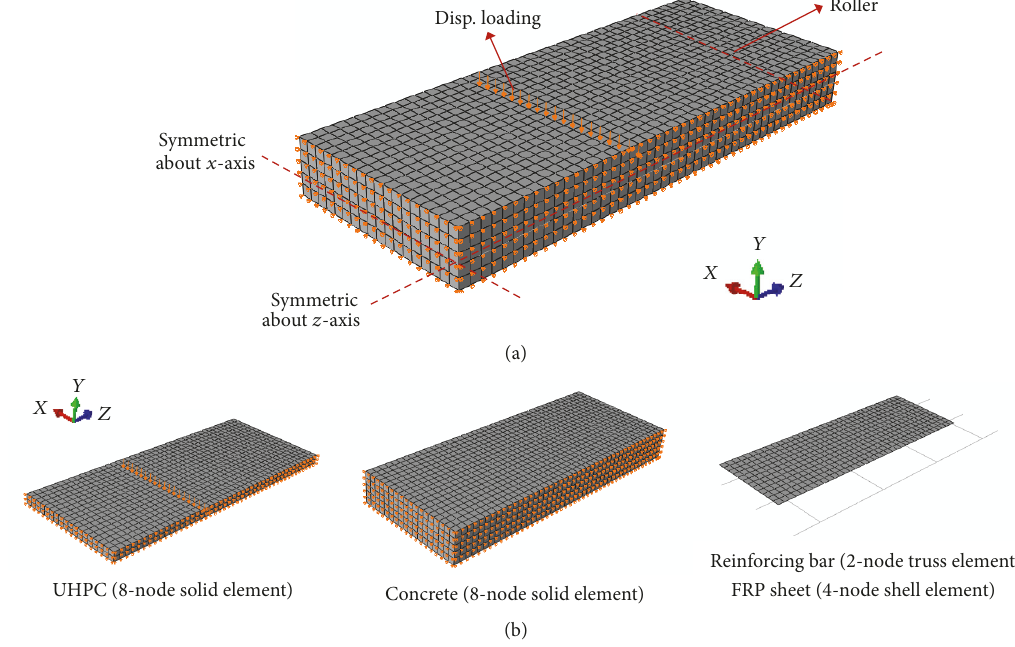
Figure 9: FE models: (a) FE model and boundary conditions and (b) elements for HPC-CFRP retrofit model.